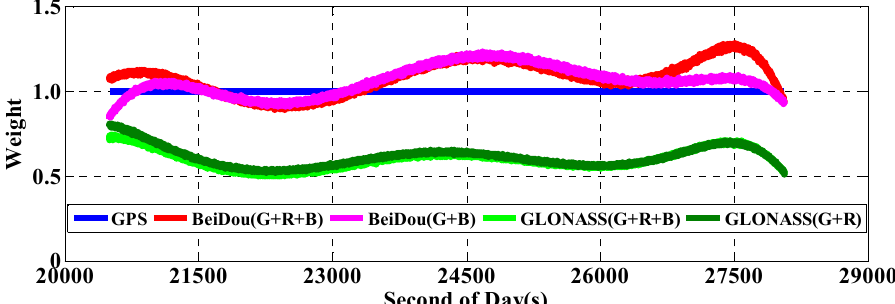
Figure 12. Weight of GPS, BeiDou, and GLONASS calculated by the PPP/INS tightly coupled integration using G + R + B, G + R, G + B data by the HVCE based adaptive Kalman filter; here, “GNSS (X)” means the weight of “GNSS” calculated in the “X” PPP/INS integration mode. Remote Sens. 2016 , 8 , 553